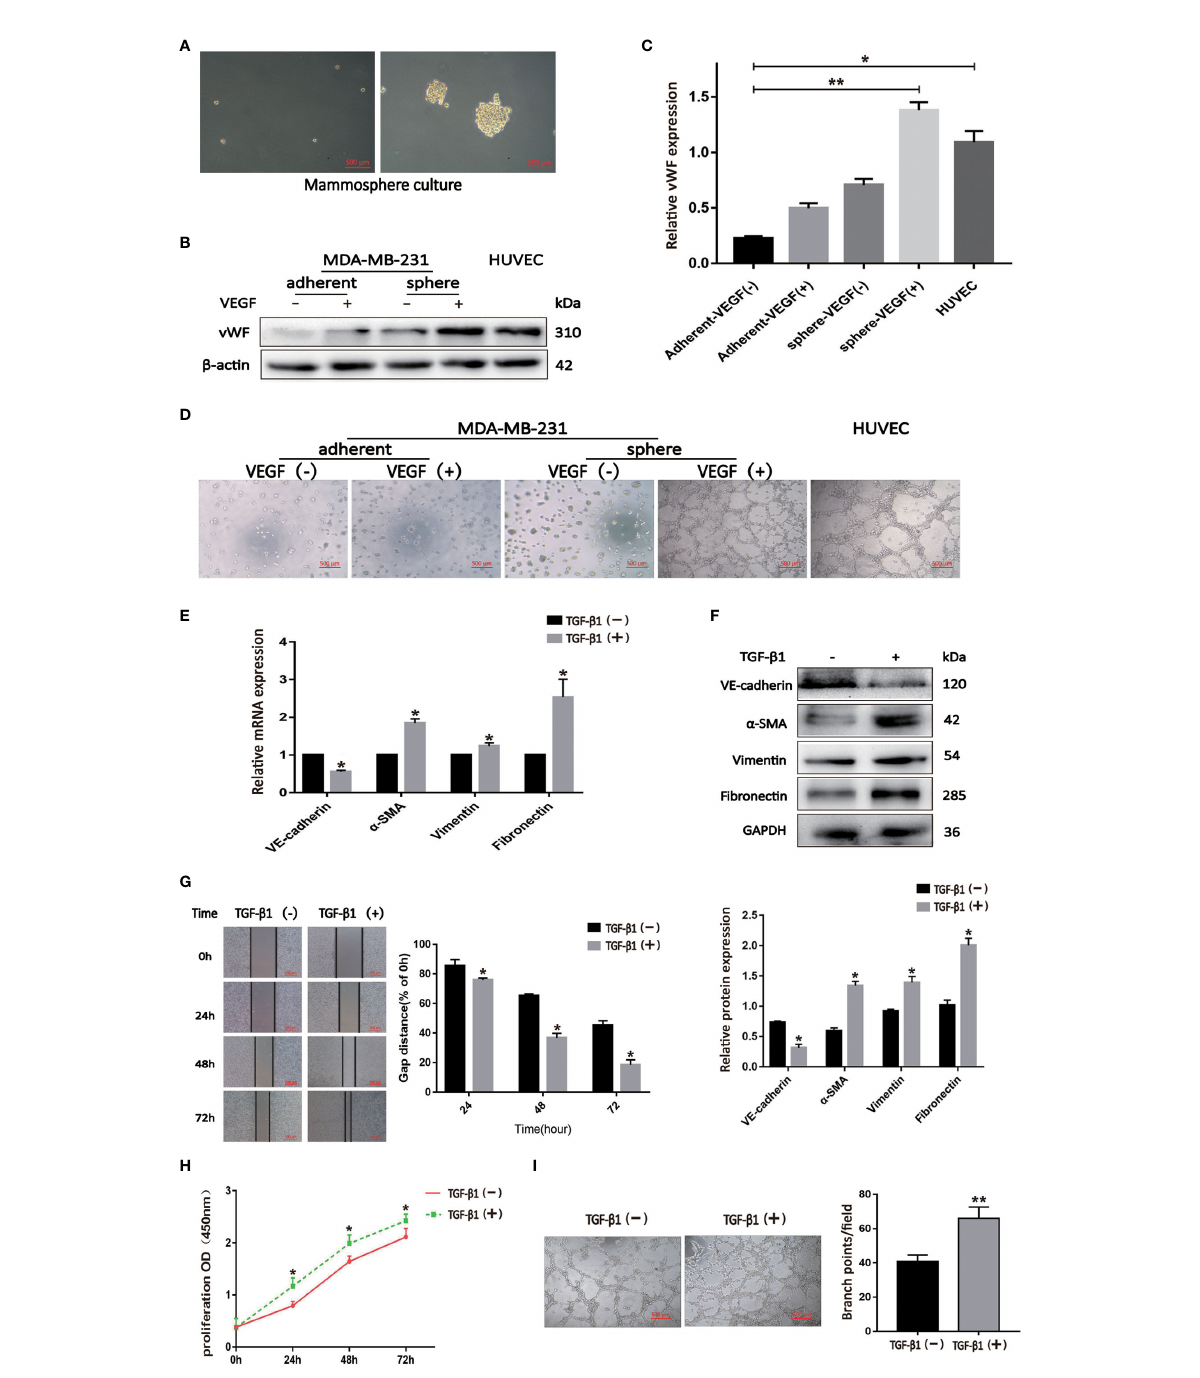
FIGURE 3 TGF- b 1promoted migration, proliferationandangiogenesisofBCSLCsbyinducingEndMT. (A) Imageof BCSLCs. (B) Westernblot wasperformedto measurethevWFexpression. (C) Proteinband intensity of vWFwasquanti fi edby westernblot. *p<0.05and**p<0.01versusAdherent-VEGF(-)group. (D) Representativeimagesof capillary-like structuresonmatrigelformedbyadherentormammosphere-culturedMDA-MB-231treatedwithorwithoutVEGF. (E, F) ThemRNAandproteinexpression of EndMTmarkers indifferentiated-endothelialBCSLCstreatedwithorwithout TGF- b 1. (G) Cellscratchwound- healingassay was performed tomeasurethe migrationofdifferentiated-endothelialBCSLCstreatedwithorwithout TGF- b 1. (H) CCK-8 assaywas performed tomeasuretheproliferation of differentiated-endothelialBCSLCstreated withorwithout TGF- b 1. (I) Matrigel tube-formationassay was performed tomeasurethetube-formationability of differentiated-endothelial BCSLCstreatedwithorwithoutTGF- b 1. *p< 0.05 and **p<0.01versus TGF- b (-)group. Alldatawererepresentativeof three independent experiments. Means±SDwere